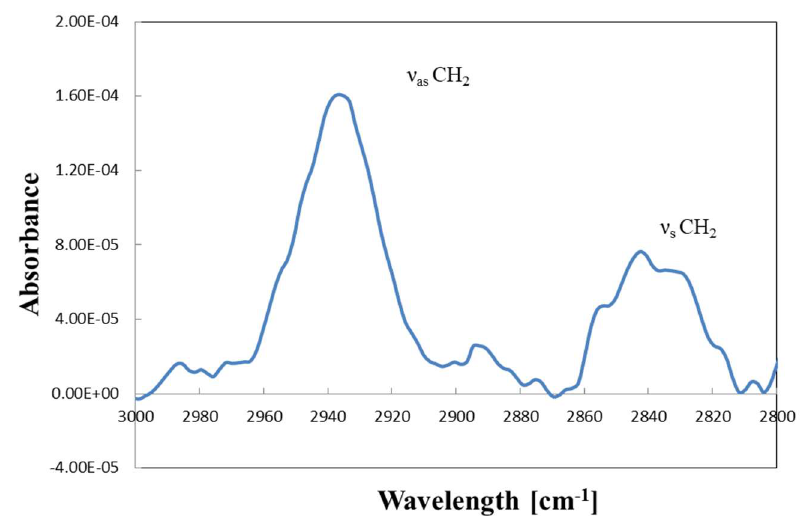
Figure 7. Fourier-transform infrared-reflection absorption spectroscopy (FTIR-RAS) profile of the MPTS monolayer adsorbed on the glass plate.